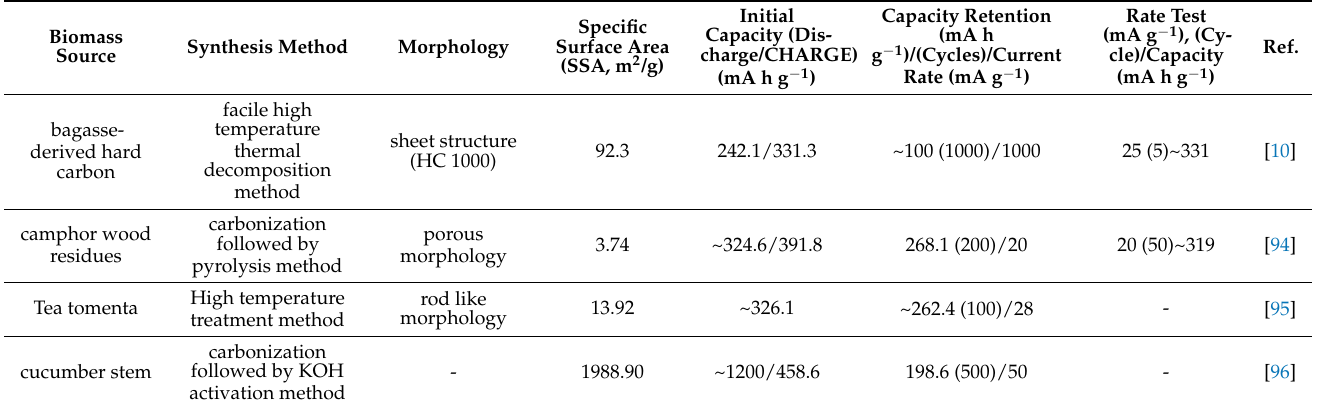
Table 2. Comparative electrochemical performance of biomass-based carbon material anodes for